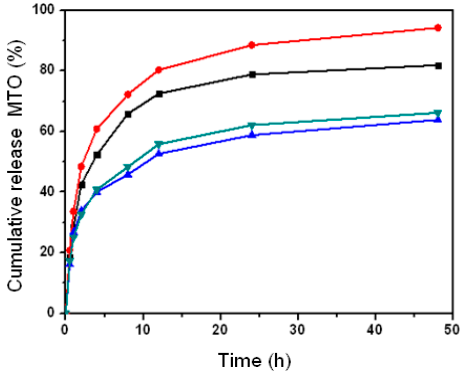
Figure 10. The mitoxantrone (MTO) release from pullulan nanoparticles in PBS buffer (pH 6.8) at 37 °C in vitro and acetate buffer (pH 4.0) ( ▲ : CHP − 3.11 , ▼ : CHCP; pH 6.8), ( ■ : CHCP, ● : CHP − 3.11 ; pH 4.0).